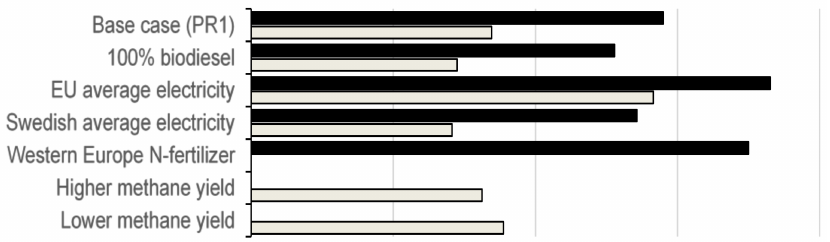
Figure 8. Results of the sensitivity analysis on GWP for various ethanol ( above ) and biogas ( below ) production